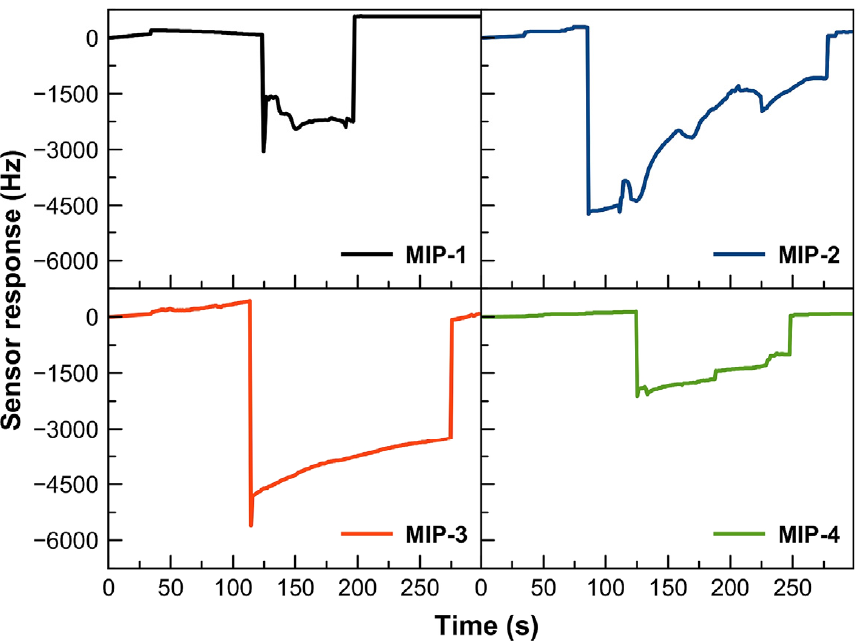
Figure 4. Sensor response of QCM devices coated with different MIP formulations containing varying ratios of monomer (MAA) and crosslinker (EGDMA).